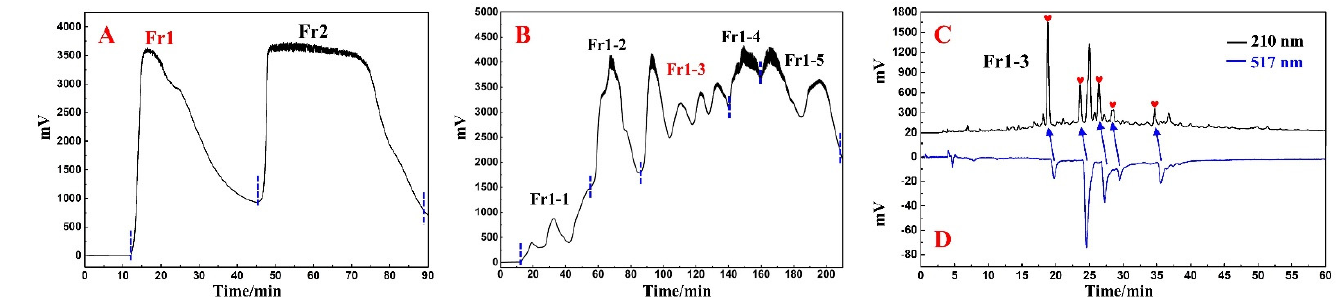
Figure 1. Chromatogram for separating D. heterophyllum extract ( A ) using silica gel MPLC system and the pretreatment chromatogram ( B ) of Fr1 from D. heterophyllum with MCI GEL ® CHP20P MPLC. The analytical chromatogram ( C ) on the ReproSil-Pur C18 AQ column and DPPH radical scavenging profile ( D ) of fraction Fr1-3 sample.